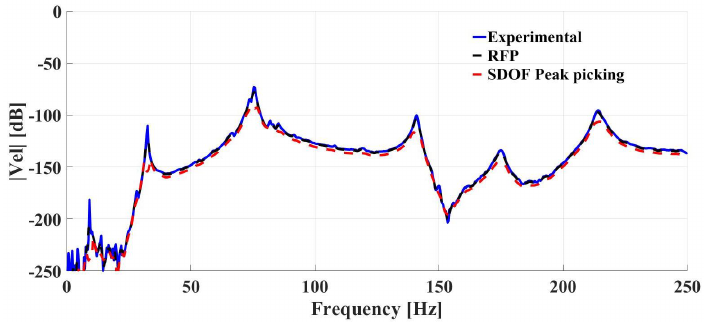
Figure 4. FRF (frequency response function) of the velocity